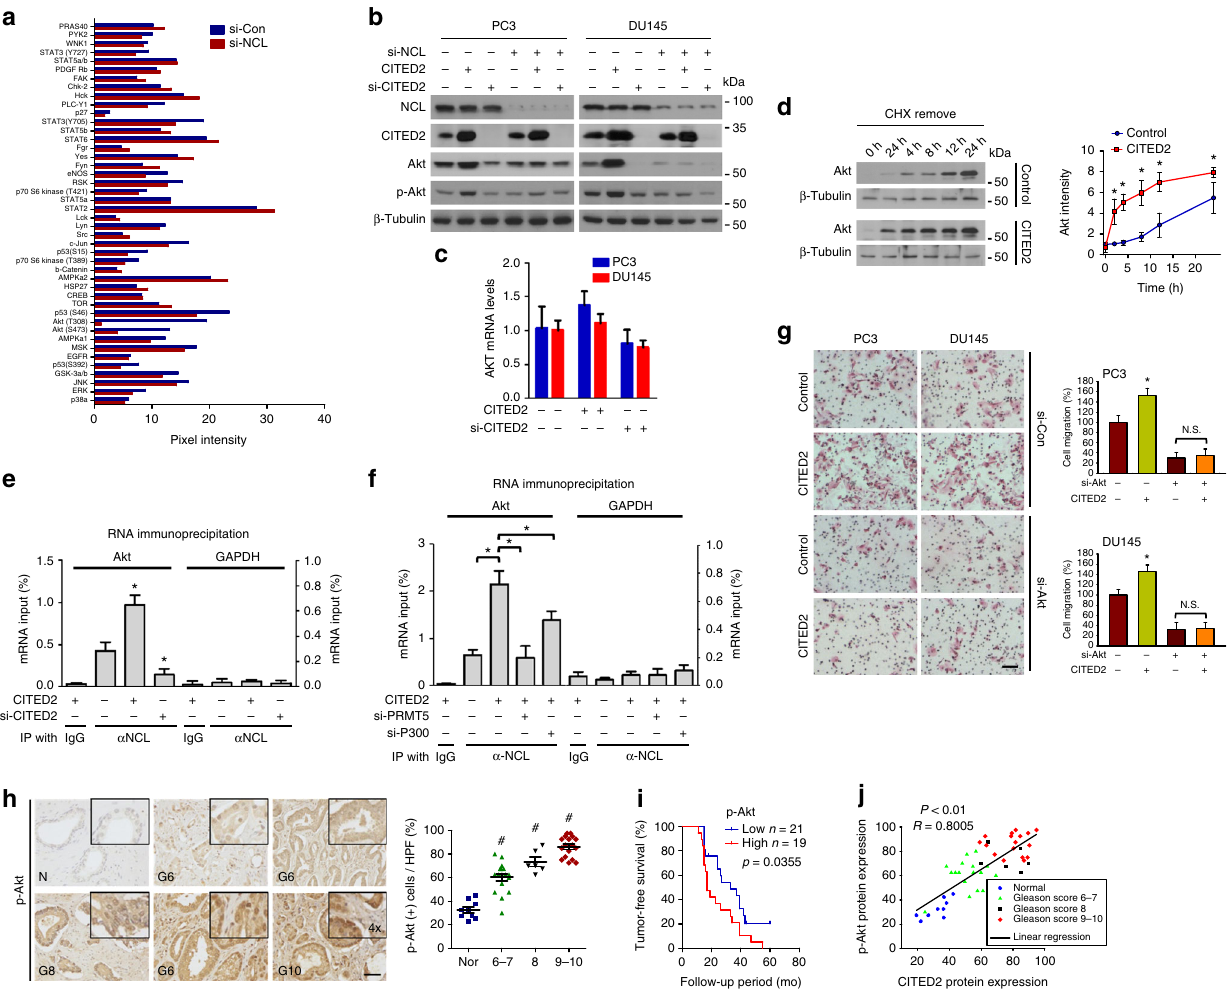
Fig. 7 CITED2 facilitates AKT synthesis through post-translational modi fi cations of NCL. a The blot spot pixel densities were analyzed by the ImageJ program. b Immunoblotting of NCL, CITED2, AKT, p-AKT, and β -tubulin in cells that were transfected with CITED2 or si-CITED2 and si-NCL. c The AKT mRNA levels in cells were measured by RT-qPCR. d DU145 cells, which had been transfected with pcDNA or CITED2, were pretreated with 100 μ M cycloheximide for 12 h. After washing out cycloheximide, cells were incubated for the indicated times. AKT synthesis levels were detected by western blotting and quanti fi ed using ImageJ. Each point represents the mean ± SD ( n = 3). e , f RNA-IP was performed to analyze the NCL binding to AKT mRNA. DU145 cells were transfected as indicated and the cell lysates were immunoprecipitated with anti-NCL or IgG. The co-precipitated AKT or GAPDH (a negative control) mRNA was quanti fi ed using RT-qPCR. Results (the mean ± SD, n = 3) were represented as percentages of IP signal/input signal (% input). g Cells that had been transfected with CITED2 and/or si-AKT were subjected to cell migration assay. Cells passing through the interface membrane were stained and counted. The relative cell migration is presented as a bar graph (the mean + SD, n = 3). N.S. ‘ not signi fi cantly different ’ among the groups. The scale bar represents 25 μ m. h Representative images of human prostate adenocarcinoma tissues immunostained with anti-phospho-AKT antibody. Abbreviations at the left bottoms of images: N normal prostate tissue (blue squares), G6 – 10 (6 – 7, green triangles; 8, black inverted triangles; 9 – 10, red diamond) Gleason scores 6 – 10 of prostate cancer (left panel). The immunostaining scores were calculated by counting stained cells and presented as dot plots (right panel). The horizontal lines in dot plot represent the means ± SE and # P < 0.05 versus the normal group by Mann – Whitney statistical analysis. The scale bar represents 50 μ m. i Kaplan – Meier tumor-free survival analysis of prostate cancer patients. P value was calculated by log-rank test. j